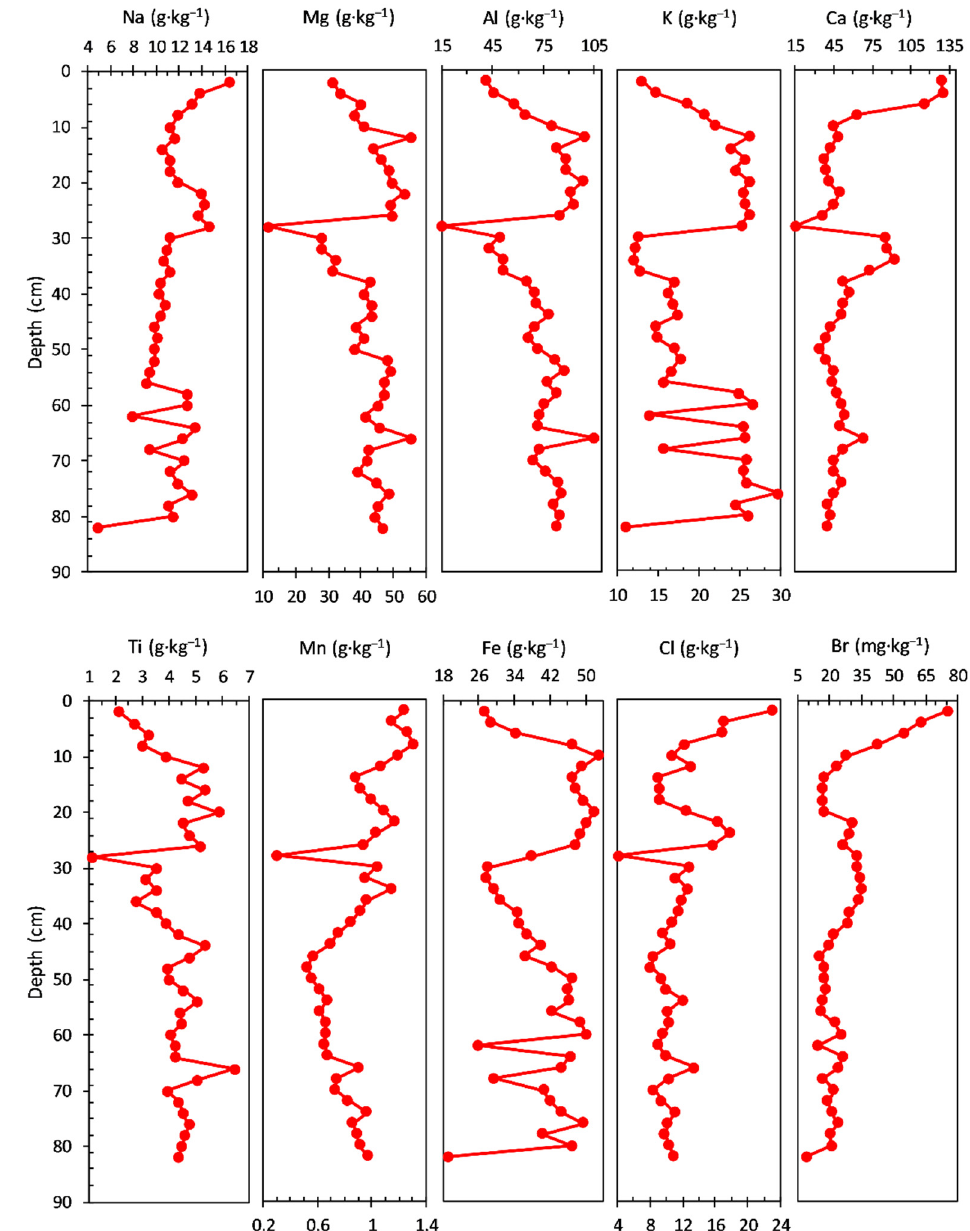
Figure 6. Vertical distribution of geochemical main elements (Na, Mg, Al, K, Ca, Ti, Mn, Fe, Cl, Br) in the Lake Caineni sediment core (82 cm depth).